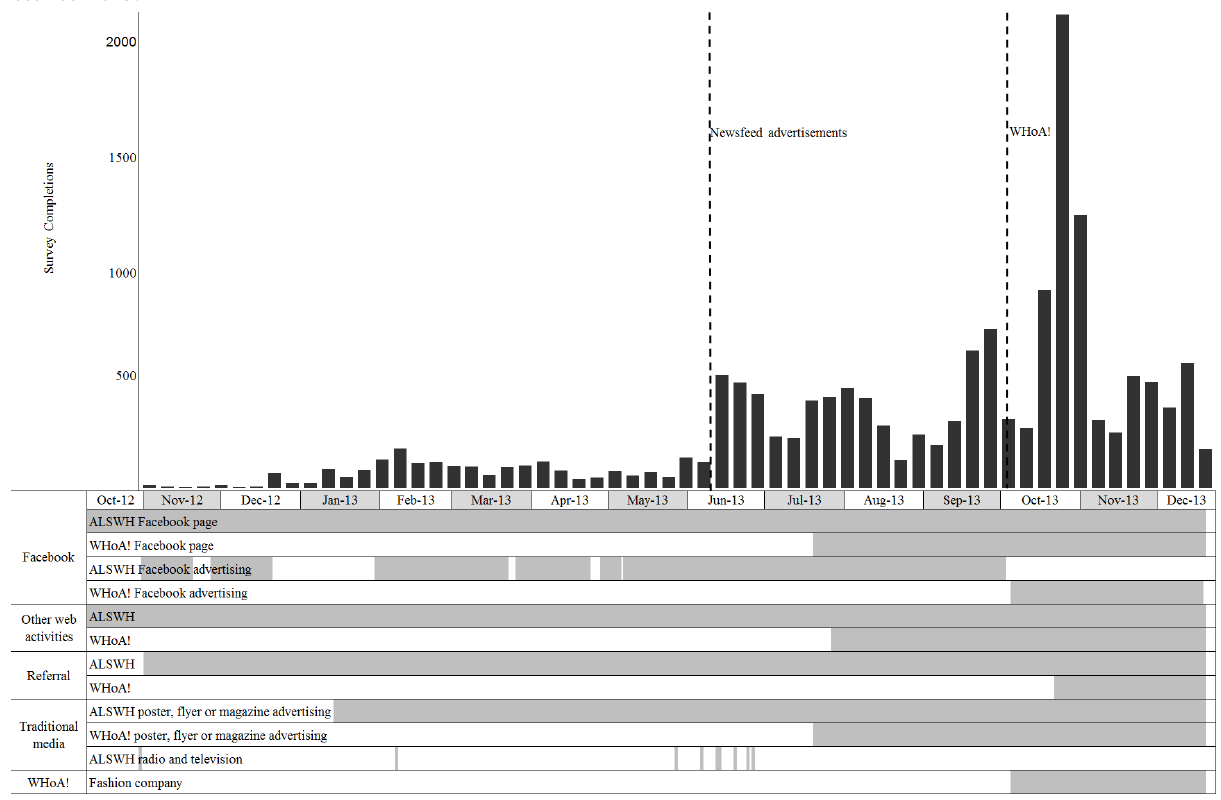
Figure 4. Survey completions by week in relation to recruitment strategies for the ALSWH 1989-95 cohort over the recruitment period October 2012 to December